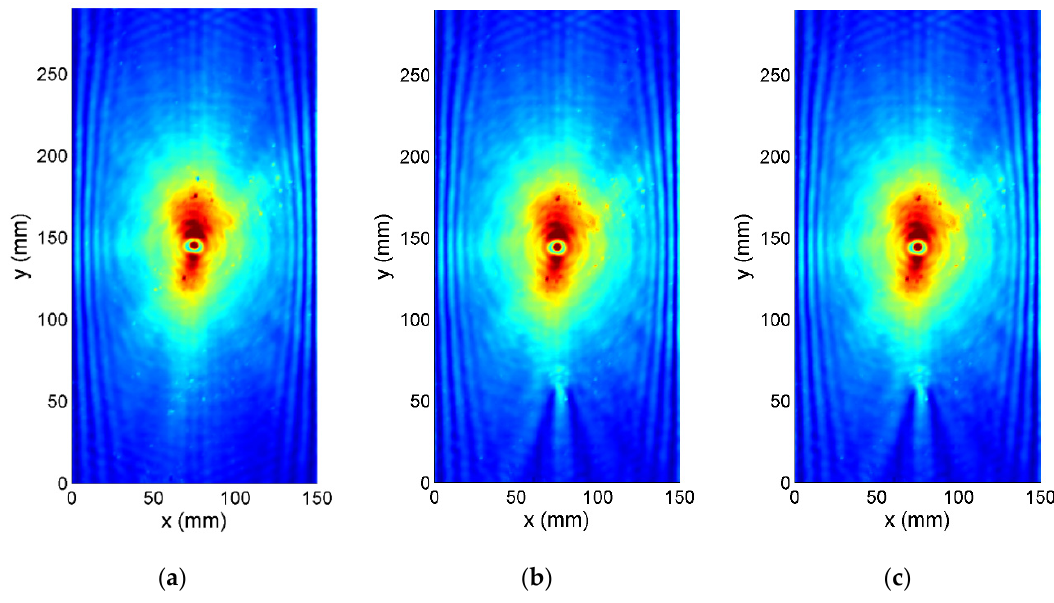
Figure 12. RMS maps: ( a ) pristine condition; ( b ) 1 h after 8 J impact; ( c ) 1 h after 5 J impact.